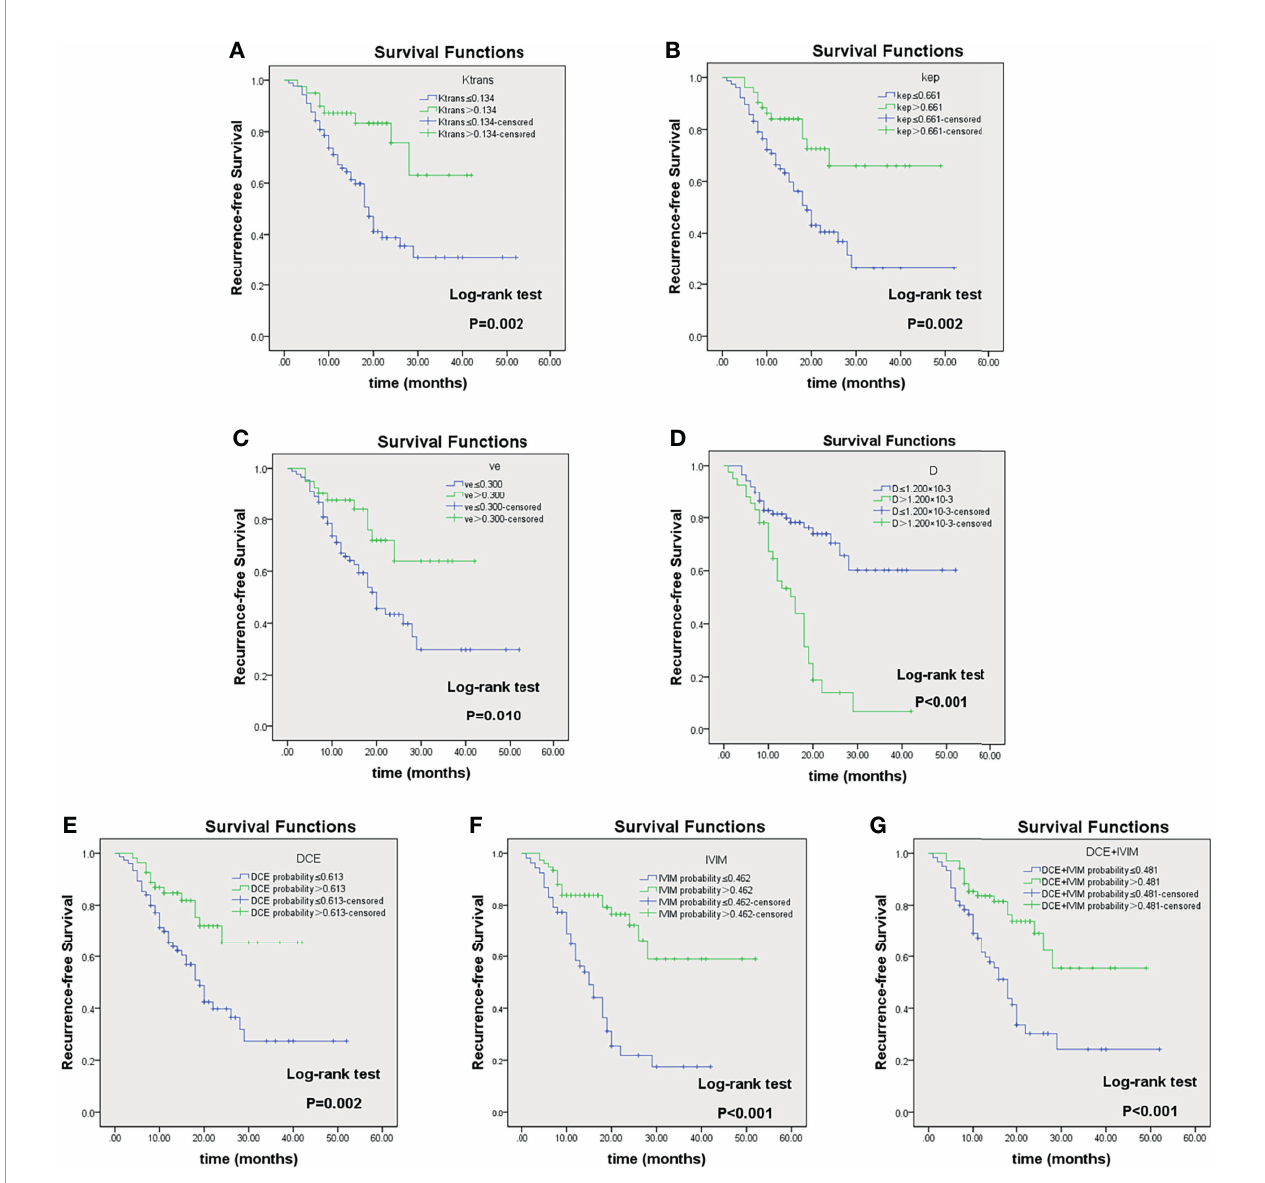
FIGURE 7 | Kaplan – Meier analyses of recurrence-free survival (RFS) in LAGC patients (n = 129) strati fi ed by category: responders and non-responders as classi fi ed according to imaging parameter cutoff values of K trans (A) , k ep (B) , v e (C) , D (D) , DCE-MRI (E) , IVIM-DWI (F) , and their combinations (G) . Reported in Table 4 . LAGC, locally advanced gastric cancer; DCE-MRI, dynamic contrast-enhanced MRI; IVIM-DWI, intravoxel incoherent motion diffusion-weighted